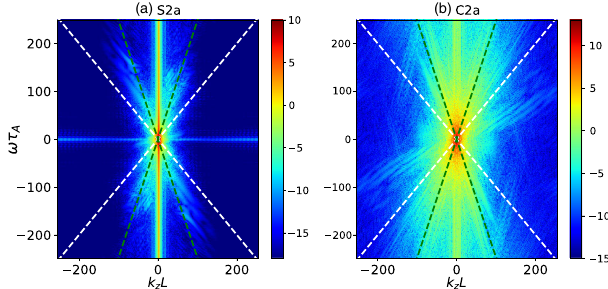
FIG. 5. Frequency spectra showing power density in ω versus k z . The color represents the logarithm of power. The left plot is from the velocity field of simulation S2a, while the right plot is for simulation C2a, again using the velocity field. The white dashed line is a reference Alfv´en-mode dispersion, while the dashed green line is an example of fast-mode